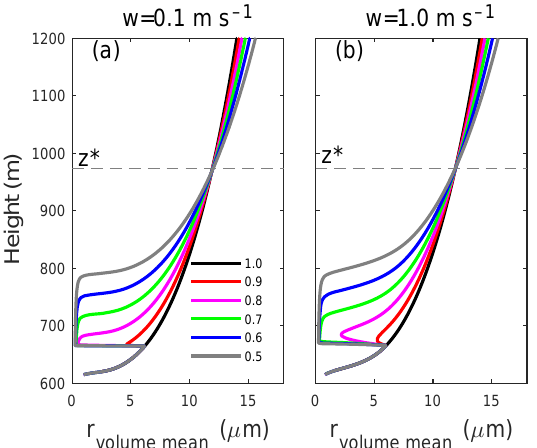
Figure 5. Volume-mean radius for a polydisperse cloud droplet population vs. height at updraft speeds of (a) w = 0 . 1ms − 1 and (b) w = 1 . 0m s − 1 and for a clean environment. Line colors repre- sent different mixing fractions χ , as in Figs. 1 and 2. The horizontal dashed line is the critical height z ∗ predicted for a monodisperse cloud droplet population with equal volume-mean